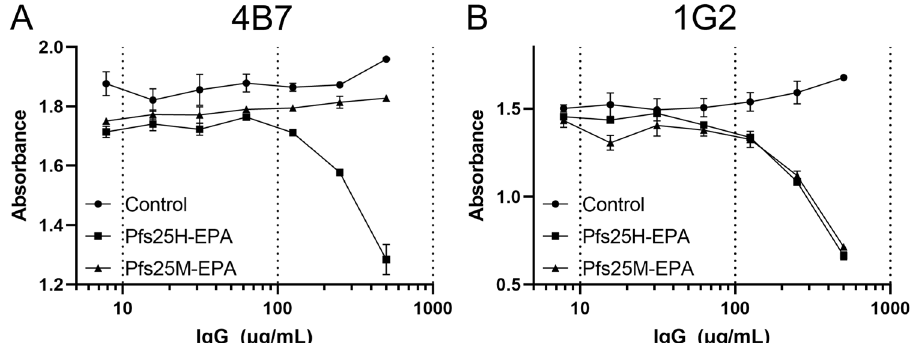
Fig. 5 Competition of pooled immune rhesus IgG with Pfs25 speci fi c mAbs 4B7 and 1G2. Competition ELISAs with HRP-labeled 4B7 ( A ) and 1G2 ( B ), using Pfs25M as the plated antigen. The concentrations of 4B7 and 1G2 were kept constant, while the pooled rhesus IgG concentration was varied to examine competition between IgG and mAbs. IgGs ( “ Control ” , “ Pfs25H-EPA ” , “ Pfs25M-EPA ” ) were puri fi ed from pooled pre-immune sera or from pooled antisera collected two weeks following a third dose. Rhesus were immunized with Pfs25H-EPA or Pfs25M-EPA formulated with Alhydrogel ® . Symbols and error bars represent the mean and standard deviation.